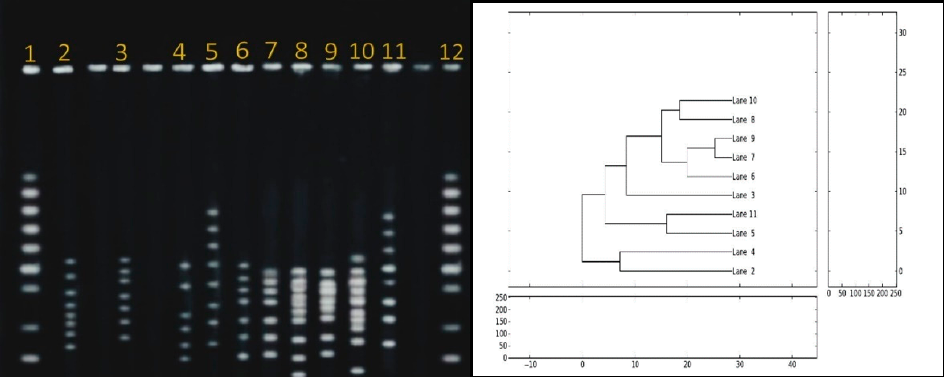
Figure 3. Dendogram with the percentage similarity among the DNA profiles of Campylobacter jejune isolated from human and poultry sources. The similarity index was estimated using the Jaccard coefficient and the dendogram was generated through UPGMA method using python version 2.6.5. Lanes 1 and 12, DNA markers; Lanes 7 and 9, human samples; Lanes 2, 3, 5, 6, 11, poultry necks; Lane 4, chicken wings; Lanes 8 and 10, poultry cloaca.